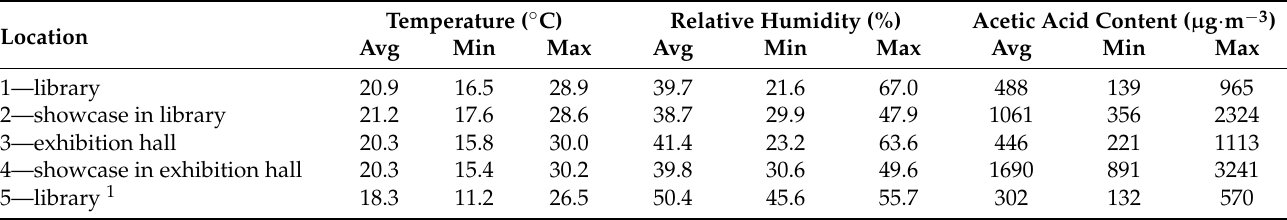
Table 1. Values of temperature, relative humidity, and acetic acid in the